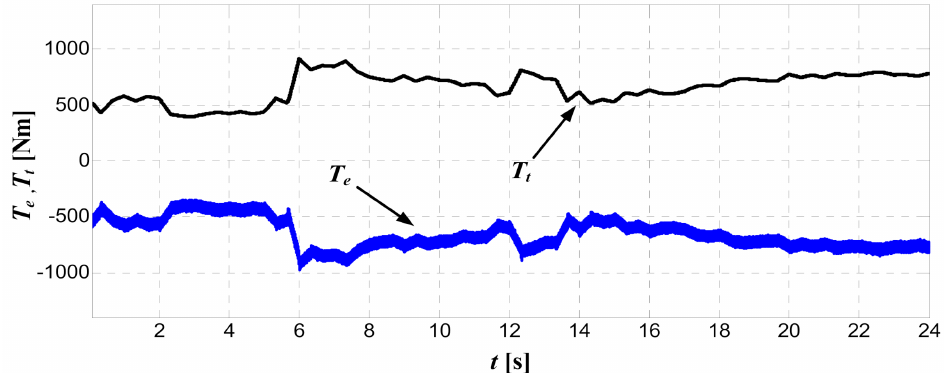
Figure 21. The courses of electromagnetic torque T e (with reverse sign) of PMSG and mechanical torque T t of wind turbine.